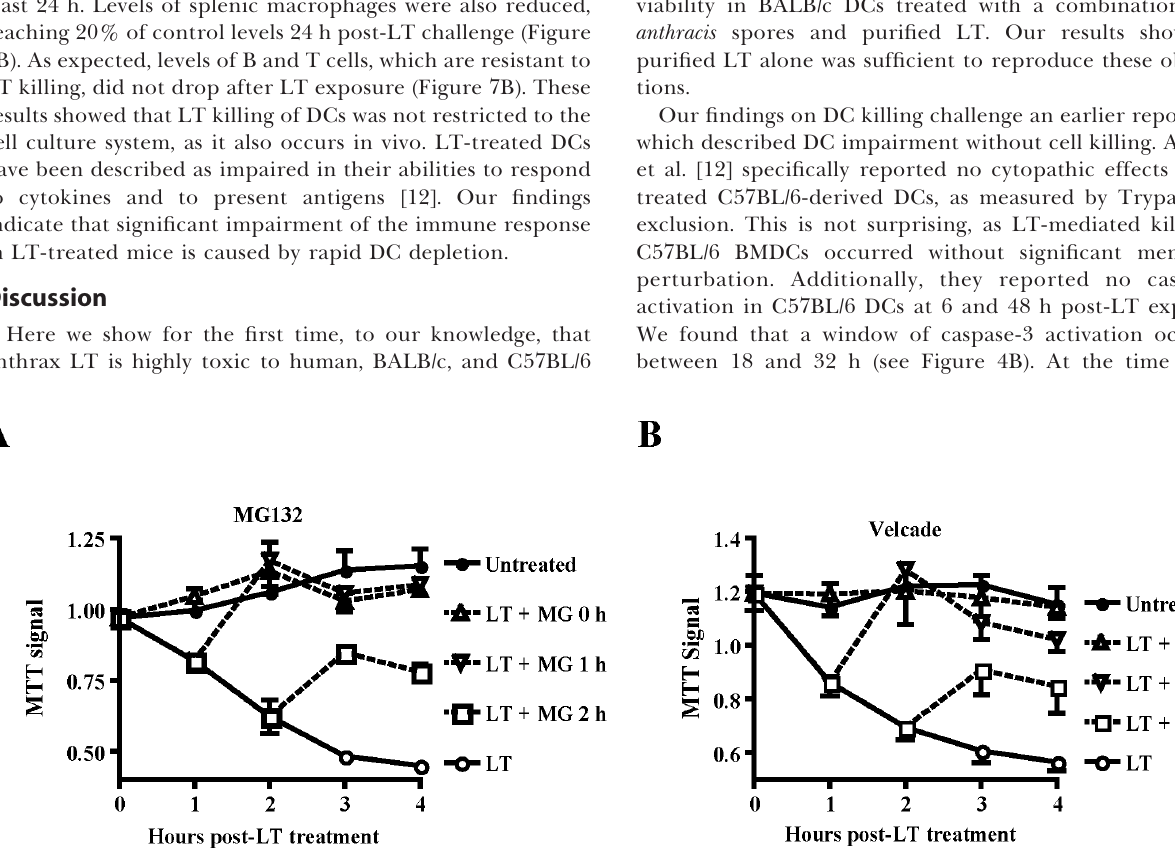
Figure 6. Proteasome Inhibitors Block LT-Mediated Killing of BALB/c-Derived DCs Proteasome inhibitors MG132 (10 l M) (A), or Velcade (0.1 l M) (B) were added either simultaneously with LT or 1 or 2 h post-LT exposure, and cell viability was determined by MTT assay. Mean þ standard deviation of four independent experiments are shown. DOI: 10.1371/journal.ppat.0010019.g006